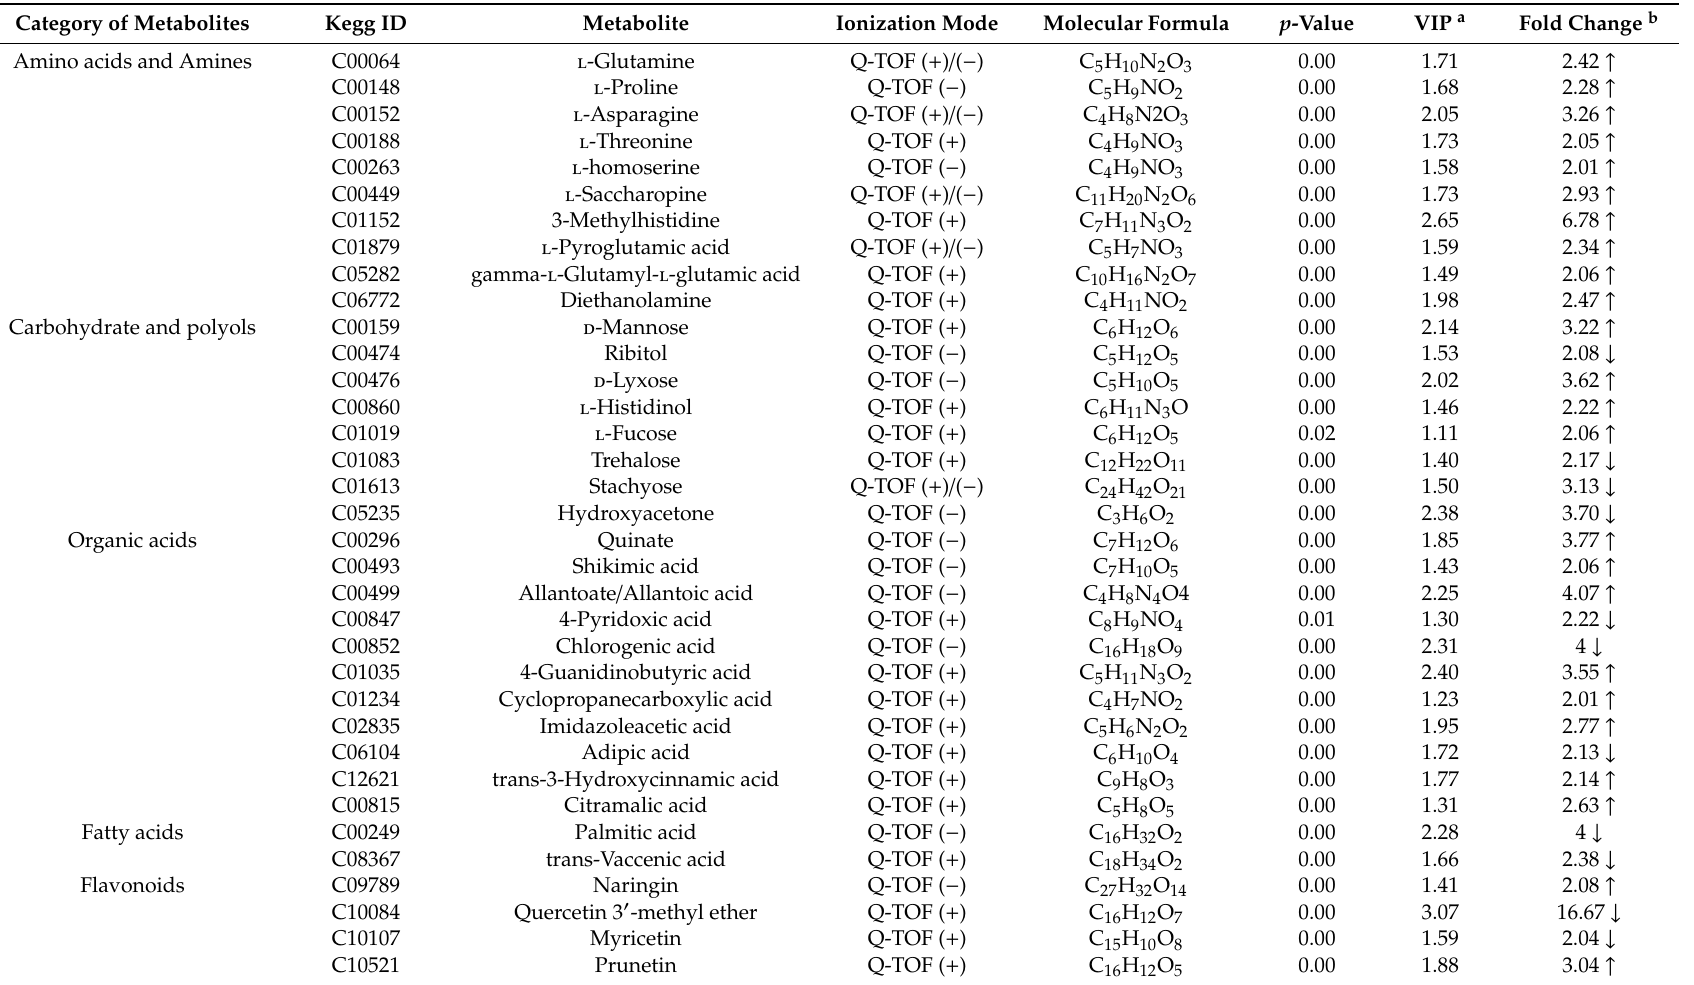
Table 2. Relative concentration and fold changes of metabolites in P. tenuiflora seedlings under alkalinity stress after mycorrhizal inoculation. Category of Metabolites Kegg ID Metabolite Molecular Formula Amino acids and Amines